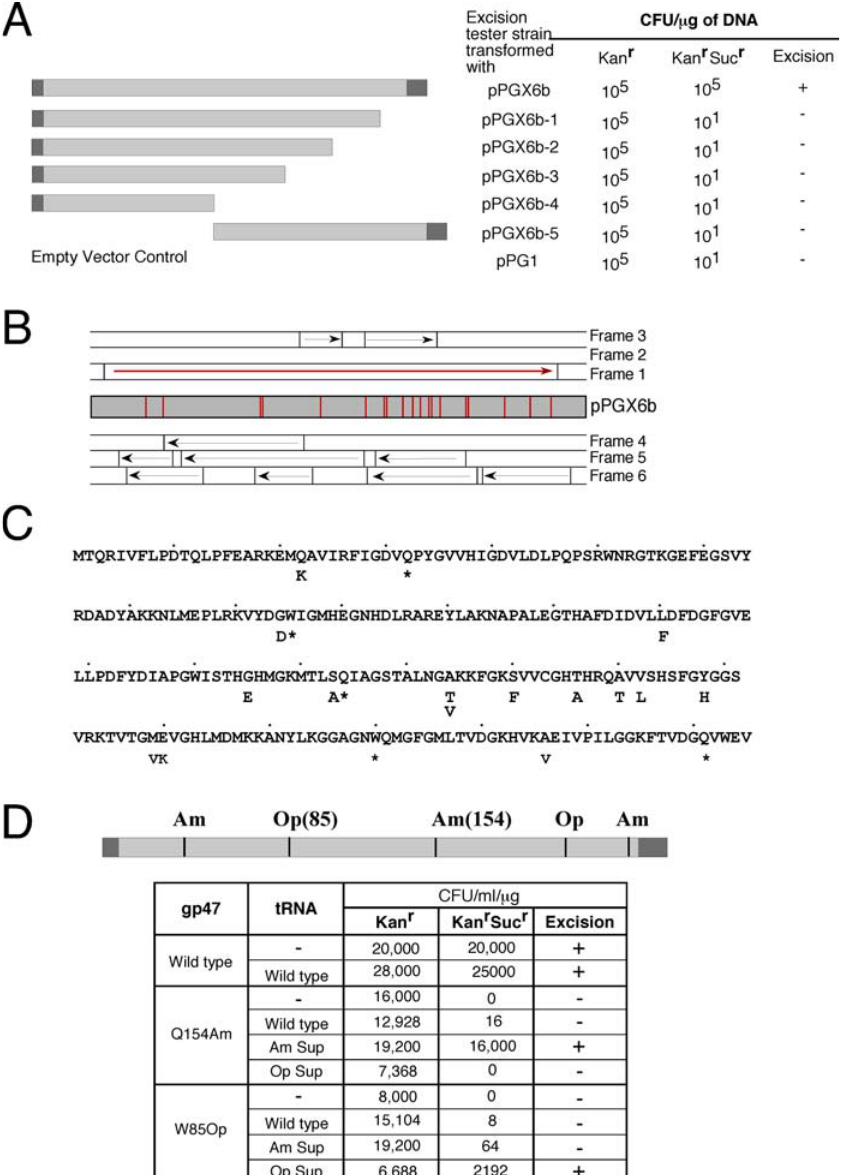
Figure 4. Confirmation of Bxb1 gp47 as the Phage RDF (A) The solid bar shows the portion of Bxb1 DNA from 35,976–36,811 bp contained within pPGX6b with the regions flanking gene 47 in dark grey. Truncation derivatives of pPGX6b were constructed as shown and tested for excision activity as in Figure 1. The number of sucR colonies obtained upon